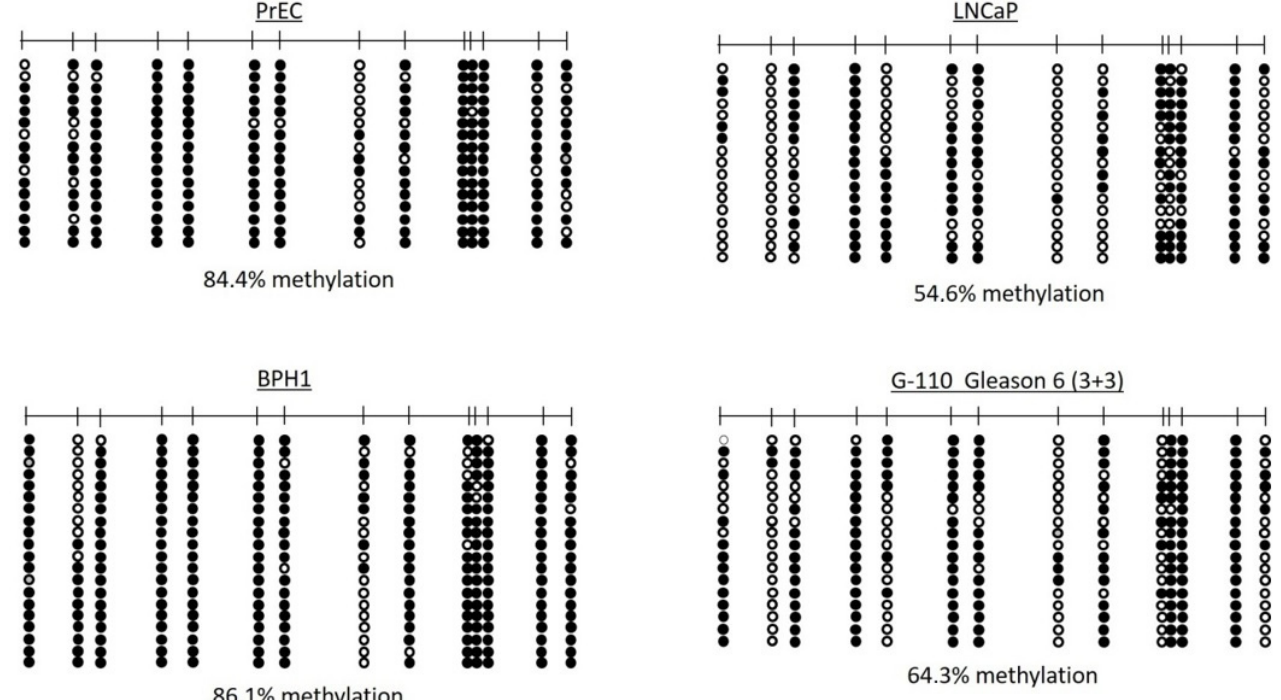
Figure 3. Lollipop diagrams of the bisulfite genomic sequencing analyses of the methylation status of each CpG of the KIR2DL3 promoter in the prostatic epithelial cell line PrEC, the PCa cell line LNCaP, one BPH tissue sample of >95% BPH cells, and one PCa tissue sample of >95% cancer cells from a Gleason 6 tumor (3 + 3). Black, white, and grey circles stand for methylated, unmethylated, and undefined CpG dinucleotides, respectively.